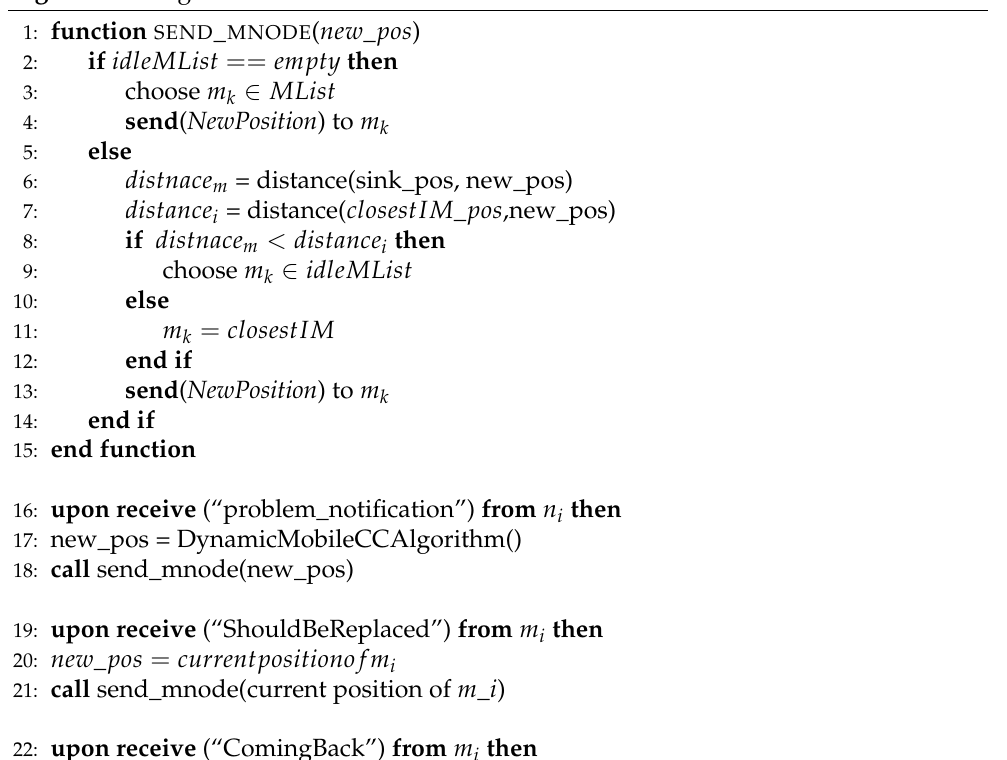
Algorithm 6 Algorithm for sink